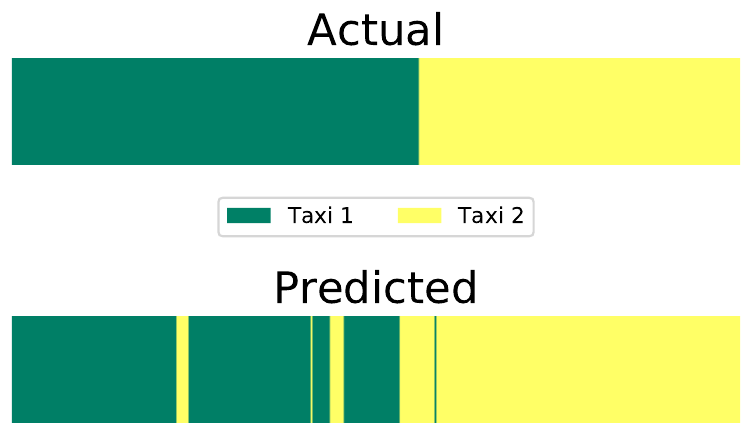
Figure 7. Prediction of the value of τ t corresponding to the taxi identity on the test. The top plot shows the sample labels, whereas the bottom plot shows the predicted τ t values using the AI-HMM with an accuracy of